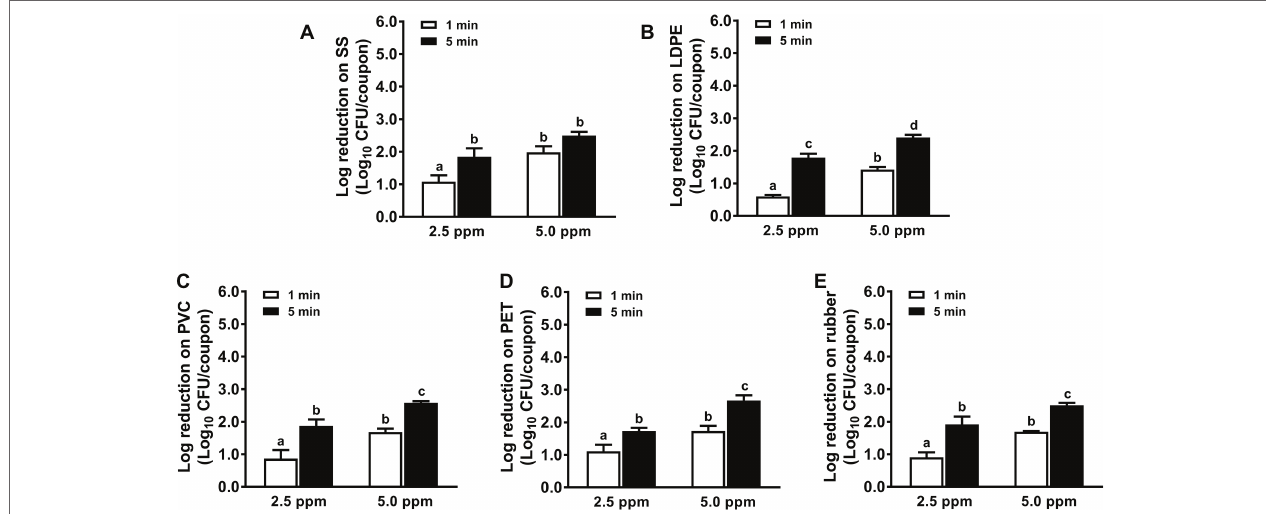
FIGURE 2 | Antimicrobial efficacy of chlorine dioxide against L. monocytogenes biofilms on food-contact surfaces. (A) Stainless steel (SS); (B) low-density polyethylene (LDPE); (C) polyvinyl chloride (PVC); (D) polyester (PET); (E) rubber. The 7-day-old biofilms on different surface coupons (15 mm × 7.5 mm) were treated with 2.5 or 5.0 ppm chlorine dioxide solution for 1 or 5 min at 22 ° C. The remaining bacteria post-sanitizer treatment were shown as means ± SEMs, n = 3. a–d Bars topped with the different letters are significantly different at p ≤